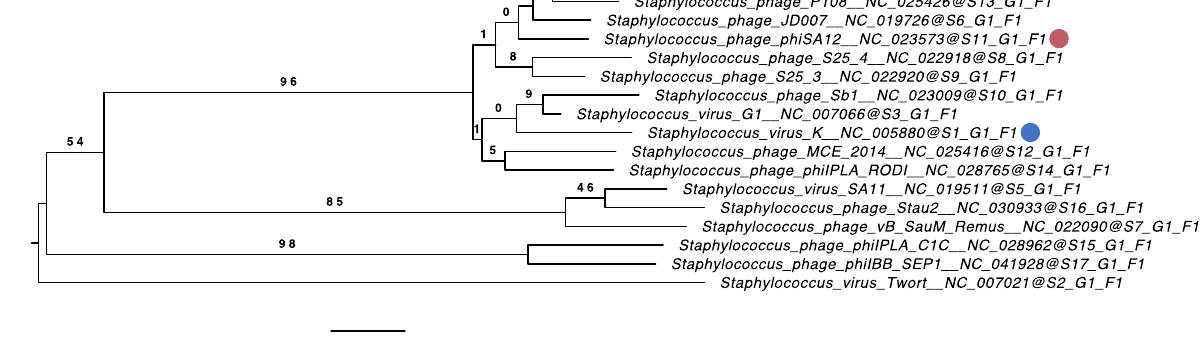
Figure 1. Phylogenetic analysis using the whole-genome sequence of ΦSA012. The phylogenetic tree was constructed by VICTOR using 16 whole-genome sequences of all Staphylococcus K-virus master species registered by the International Committee on the Taxonomy of Viruses (ICTV). The red circle indicates ΦSA012 and the blue circle indicates Staphylococcus virus K. S, G, and F after the phage names refer to species, genus, and family clusters, respectively. Bootstrap values are shown on the branch nodes, and the scale bar represents a distance of 0.03 substitutions per